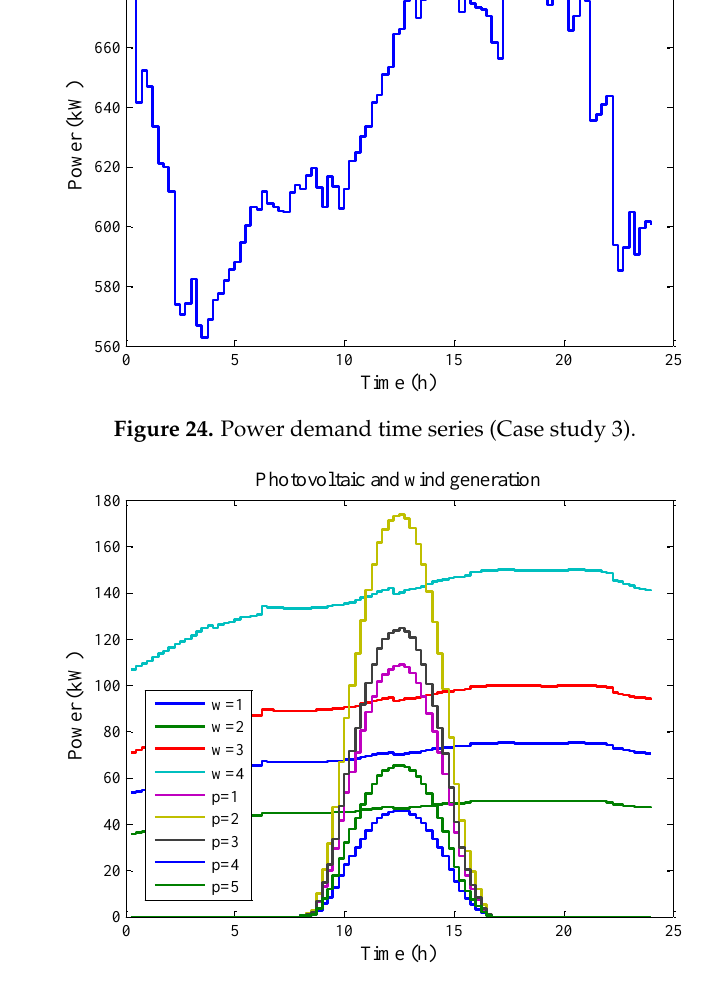
Figure 25. PV and wind power time series (Case study 3).